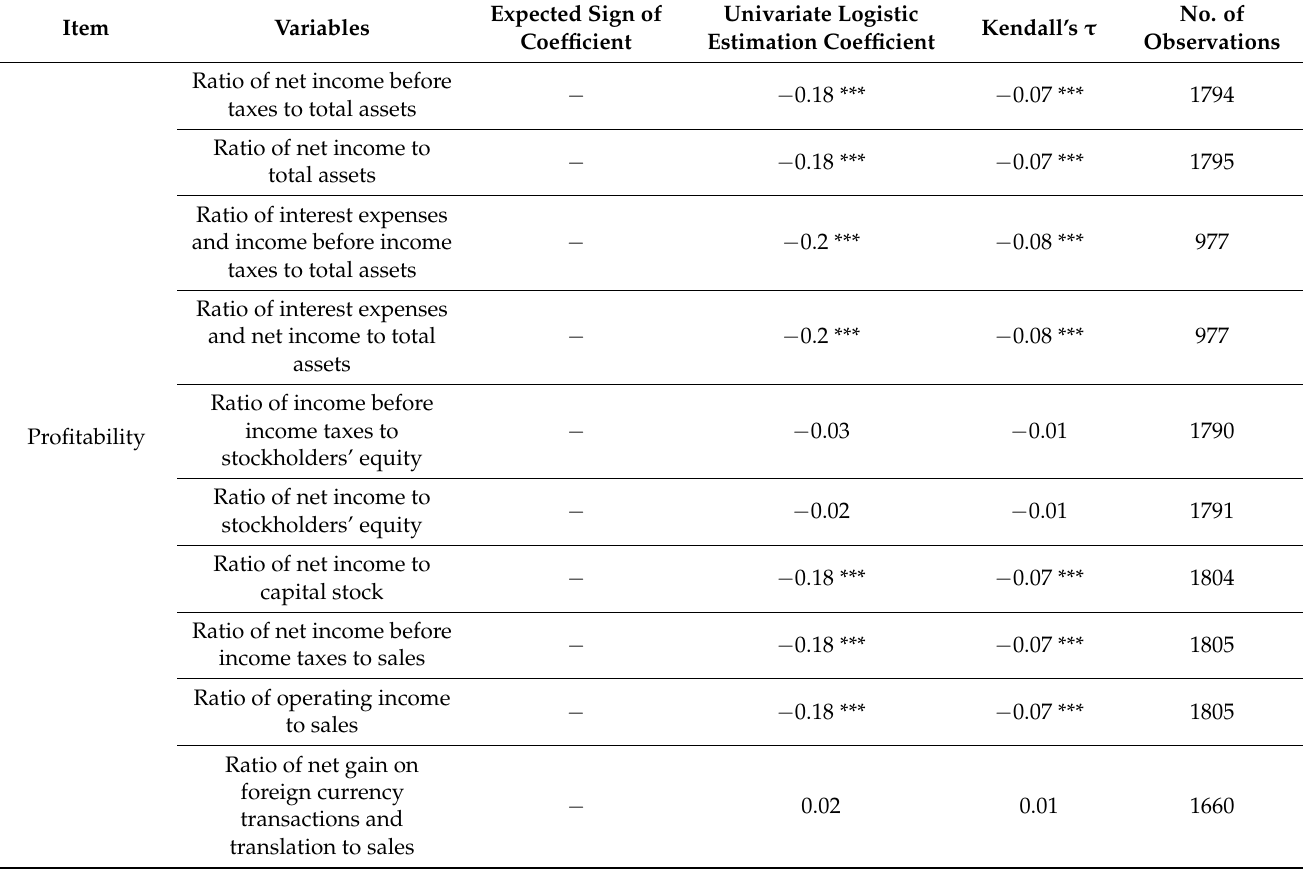
Table 6. Suitability test results for explanatory